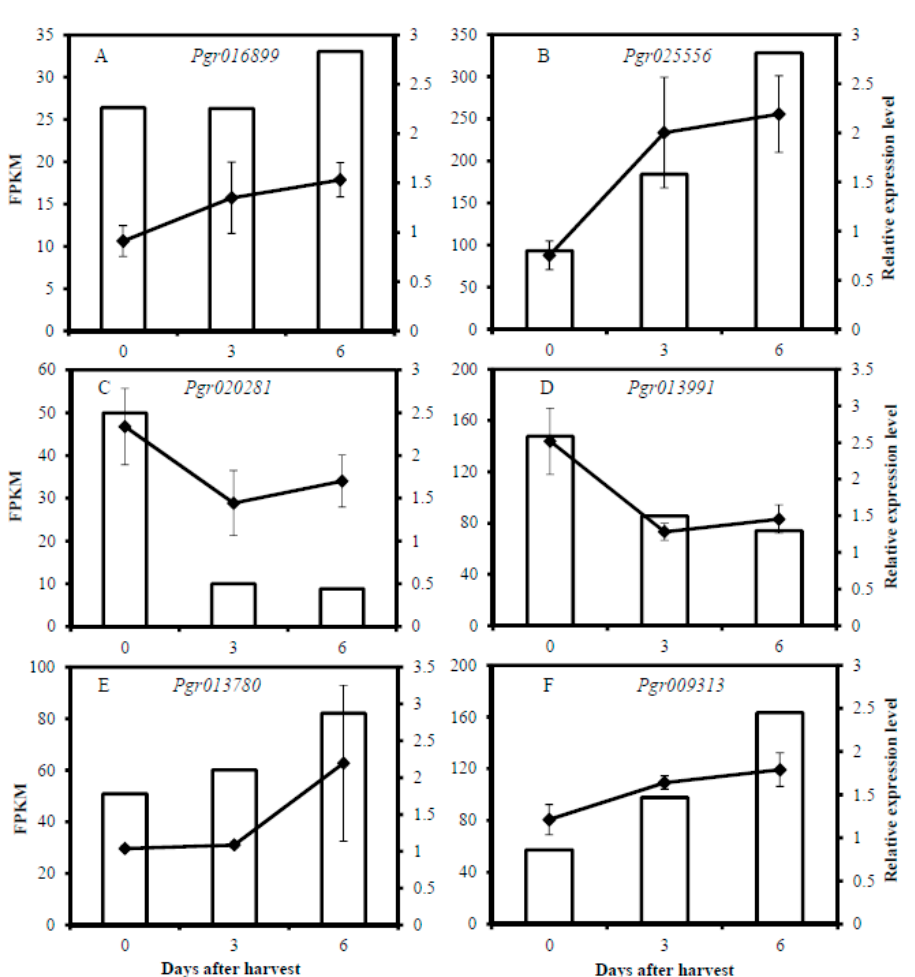
Figure 8. Relative expression levels of candidate genes by qRT-PCR and transcript amounts of candidate genes. The left y-axis is the result of RNA-seq (white histogram). The right y-axis is the relative expression level determined by qRT-PCR (black lines). The genes and their encoding enzymes are the following, ( A ) Pgr016899 , polyphenol oxidase; ( B ) Pgr025556 , phenylalanine ammonia-lyase; ( C ) Pgr020281 , superoxide dismutase; ( D ) Pgr013991 , ATP synthase; ( E ) Pgr013780 , lipoxygenase and ( F ) Pgr009313 , sucrose synthase. Vertical bars represented the standard deviation of the means of three replicates.